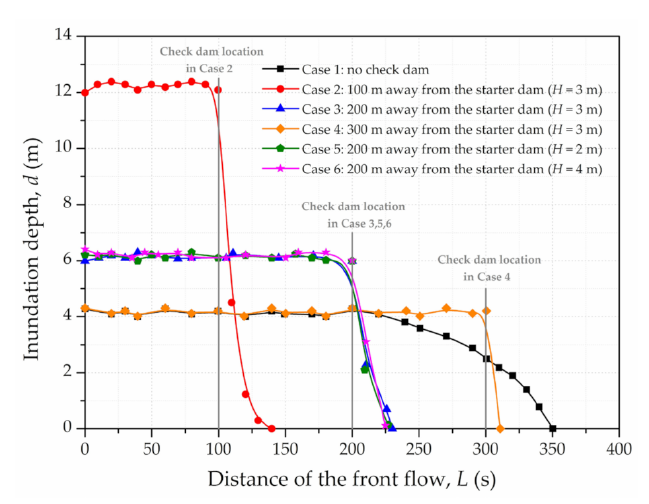
Figure 11. The inundation depth along the downstream channel.